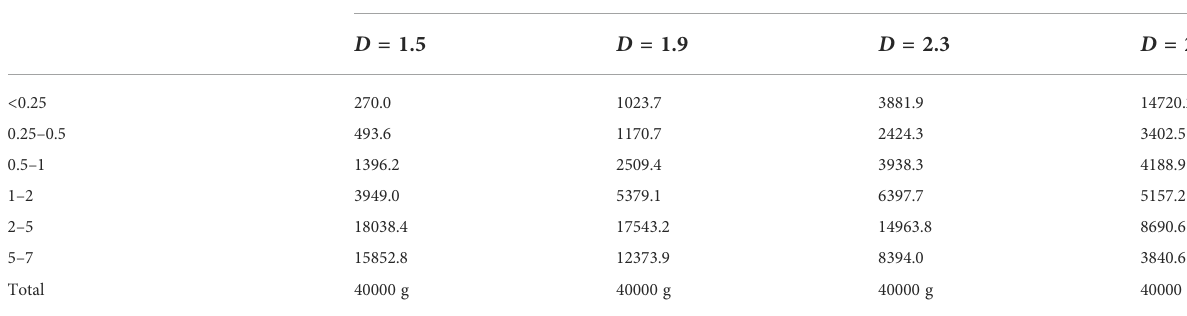
TABLE 1 Grain mass of each grain size with different fractal